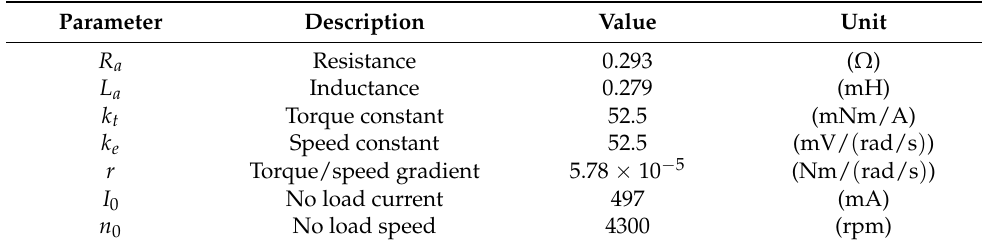
Table 1. Electric motor model